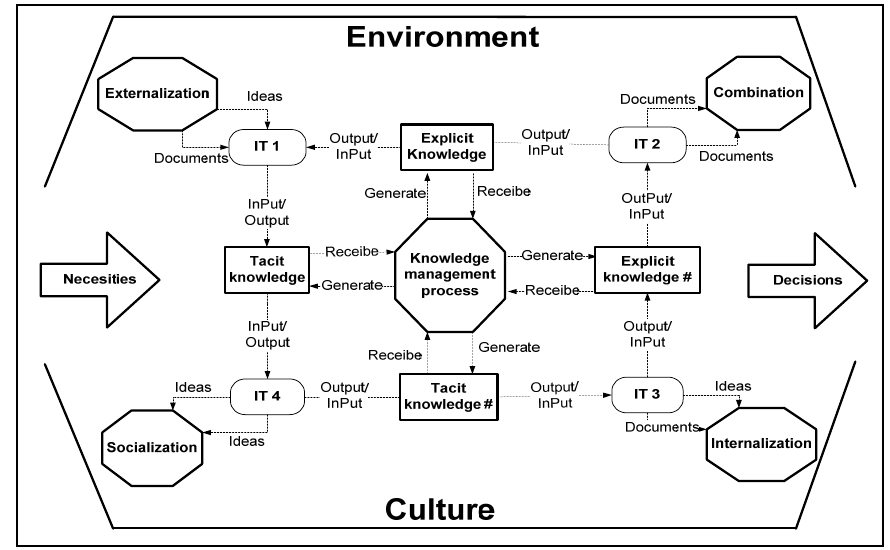
Figure 1. “KMF proposal, a conceptual perspective -An extension of Nonaka